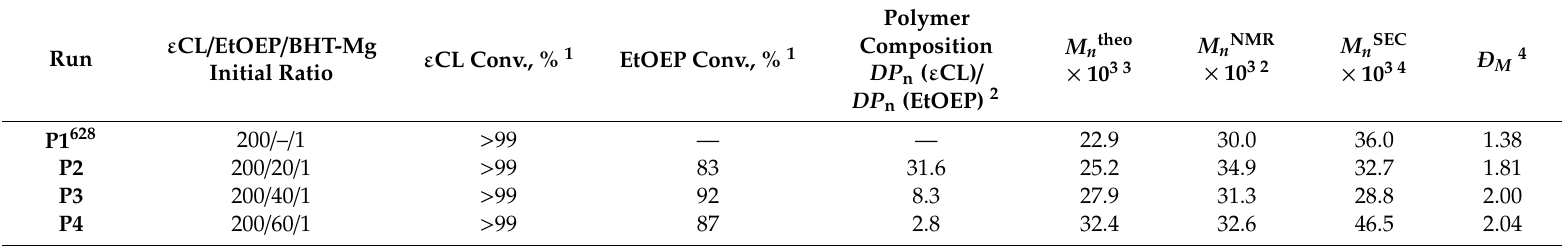
Table 1. Polymerization experimental data for BHT-Mg catalyzed (co)polymerization. Reaction conditions: CH 2 Cl 2 / THF, [ ε CL] = 2 M.